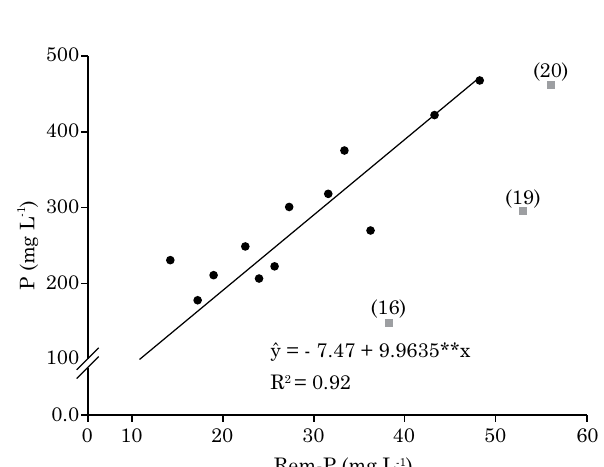
figure 4. sulfur concentration in the extract-soil of Mehlich-1, as a variable of remaining p values (Rem-P) of the soils. The three points identified for the soils ( ) were excluded from the fit. **: significant at 1 % by the t test. (│) Indicates the rem-p value for the beginning of the plateau.